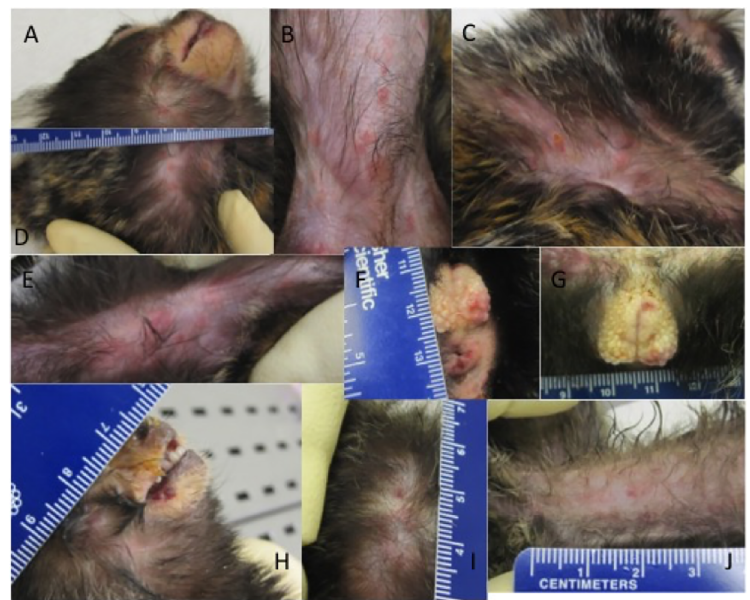
Fig 4. Rash in marmosets exposed to intranasal monkeypox virus. A rash was observed in two of the four marmosets, animal 3 (A-G) and animal 4 (H-J). Shown are the head (A), abdomen/groin (B), side of chest and left arm (C), left armpit with enlarged lymph node (D), and urogenital region (F and G) of animal 3. From animal 4, mouth and copious nasal discharge (H), back of skull (I), and lower abdomen (J). Notice that the lesion on animal 4 are in a papular/vesicular stage of rash with few pustules whereas animal 3 has a macular/papular rash that had flattened has areas hemorrhage (petechial in nature).